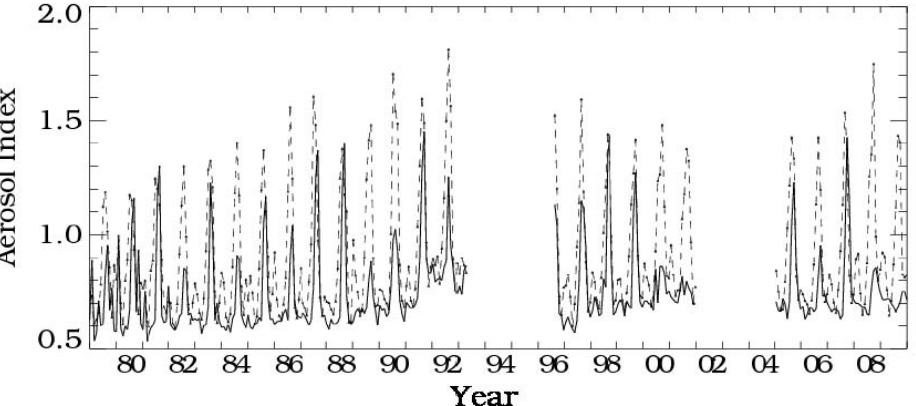
Fig. 3. Long term record of Aerosol Index over South America (solid line) and Central Africa (dashed line). See text for details.